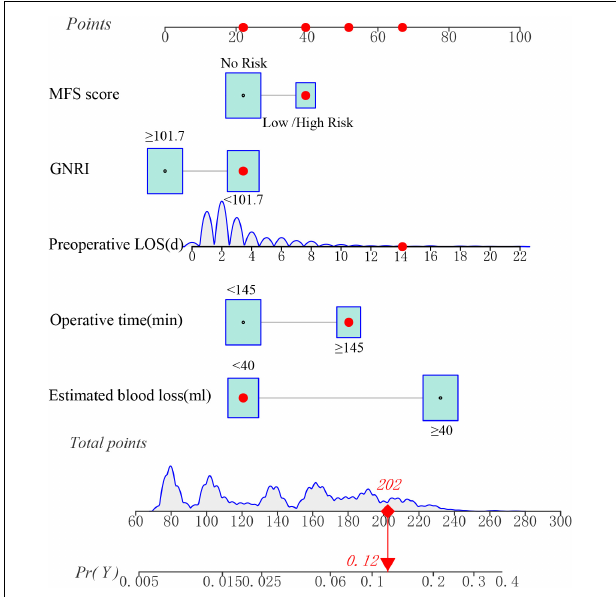
FIGURE 4 | A dynamic nomogram for predicting the risk of SSI in gynecologic oncology patients. Note: the SSI risk nomogram was developed with the MFS score, preoperative LOS, operative time, estimated blood loss, and GNRI as